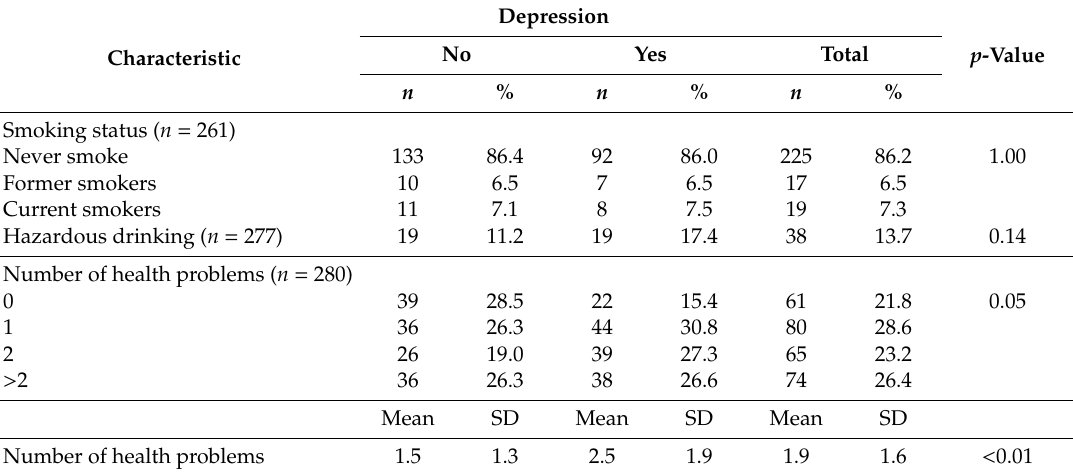
Table 3. Health status and behavior of respondents.